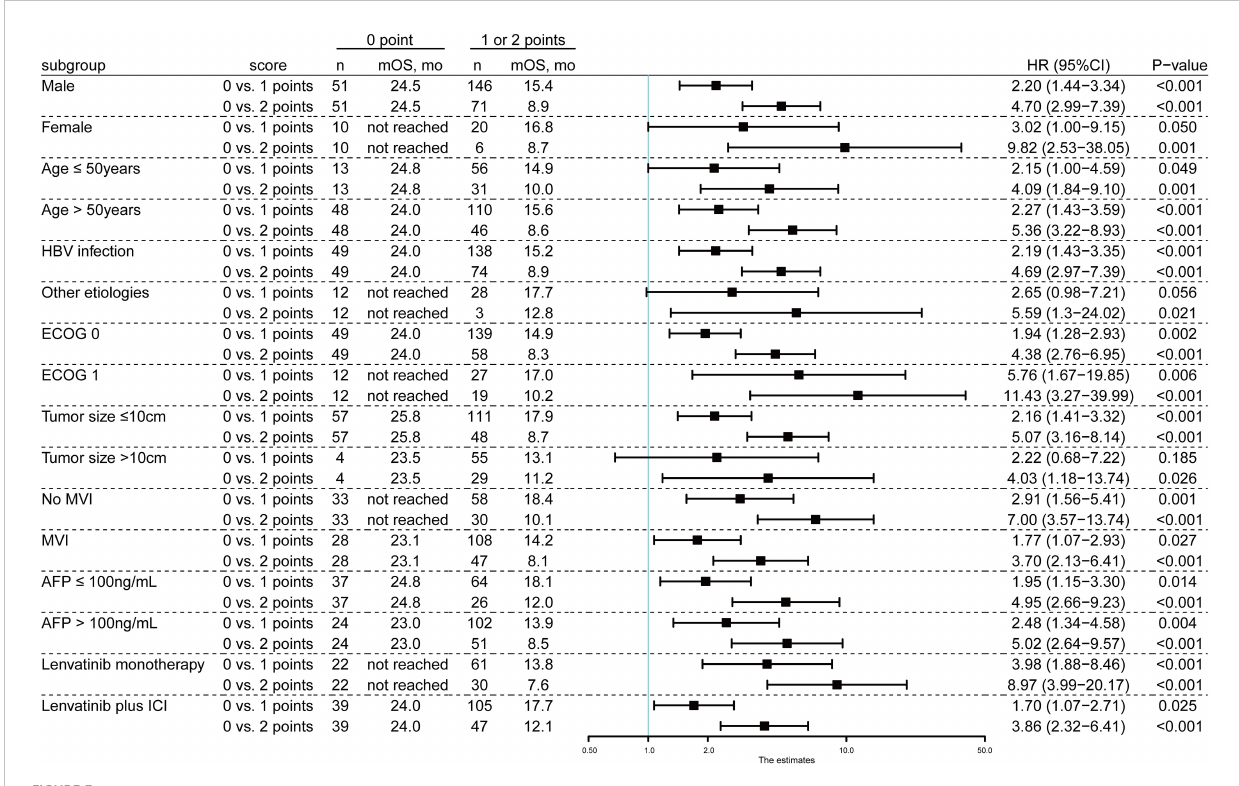
P=0.034, Figure 4C) and PFS (median PFS: 8.4 vs5.0months, P=0.028, Figure 4D) compared with lenvatinib monotherapy. Meanwhile, the lenvatinib plus ICI also improved outcomes of PIMET-high patients (median OS: 12.1 vs 7.6 months, P=0.031, Figure 4E; median PFS: 5.6 vs 4.0 months, P =0.007, Figure 4F).